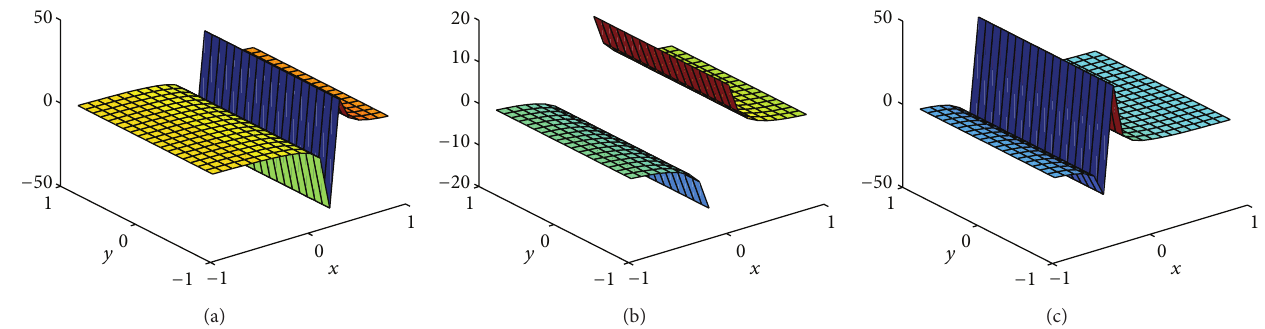
Figure 2: The solution of (DS) corresponding to V 𝑠,2 : take 𝑐 = 1 , 𝑧 0 = 0 , 𝑑 = −1/2 , 𝑘 = 0 , 𝛼 = 1 , (a) 𝑡 = −1/3 , (b) 𝑡 = 0 , and (c) 𝑡 = 1/3 .